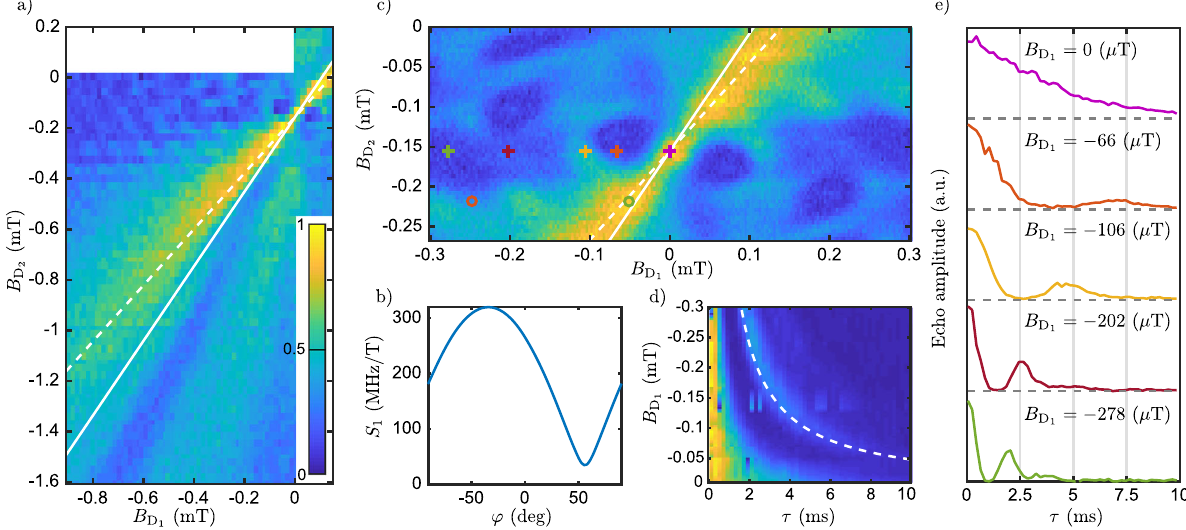
Fig. 2 Spin echo measurements with magnetic fi elds. a Map of the relative Hahn echo amplitude normalized to the maximum amplitude for a range of magnetic fi elds in the D 1 -D 2 plane, with the pulse separation fi xed at τ = 5 ms. b Numerically computed S 1 gradient for the 2.497 GHz transition in the D 1 -D 2 plane, as a function of the angle φ to the D 1 axis. The solid lines in a , c show the expected minimum at φ = 55.9 ∘ , while the dashed lines show the estimated angle of maximum echo amplitude, at an angle of φ = 48 ∘ . They agree within the expected error of the fi eld direction and of the cuts of the crystal surfaces. c Similar to the plot in a , but showing data taken at a higher resolution in the fi eld step. The color-coded crosses and circles show the fi eld values at which the echo decays shown in e and in Fig. 3b and c, were recorded, respectively. d Map of the echo decays as a function of time delay τ , for a range of fi elds along the D1 axis, B D dashed line shows the yttrium Larmor period. Examples of decay curves from the map are shown in e , from top to bottom ¼ 0 ; (cid:3) 66 ; (cid:3) 106 ; (cid:3) 202 ; (cid:3) 278 μ T, indicated with crosses in c B D 1